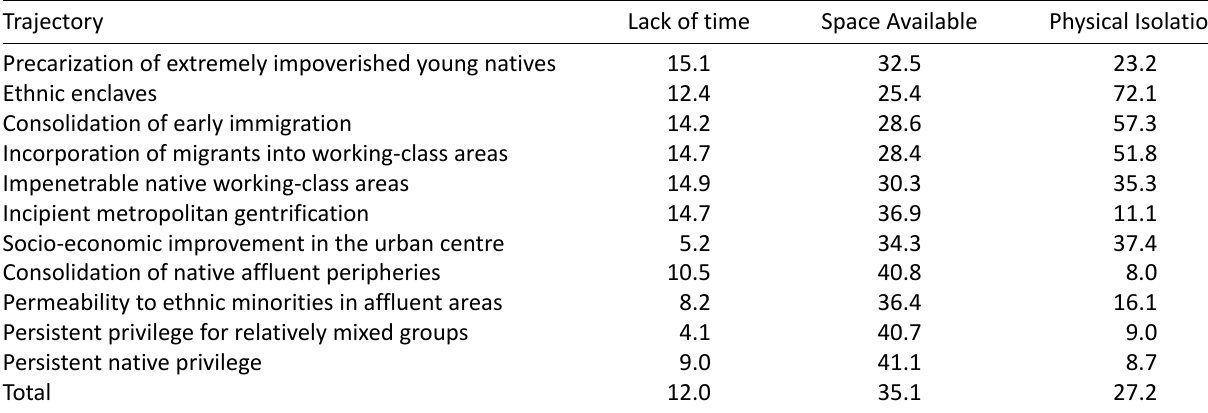
Table 7. Average percentage of the variables of lack of time, available space and physical isolation, according to the trajec- tory of social residential inequality